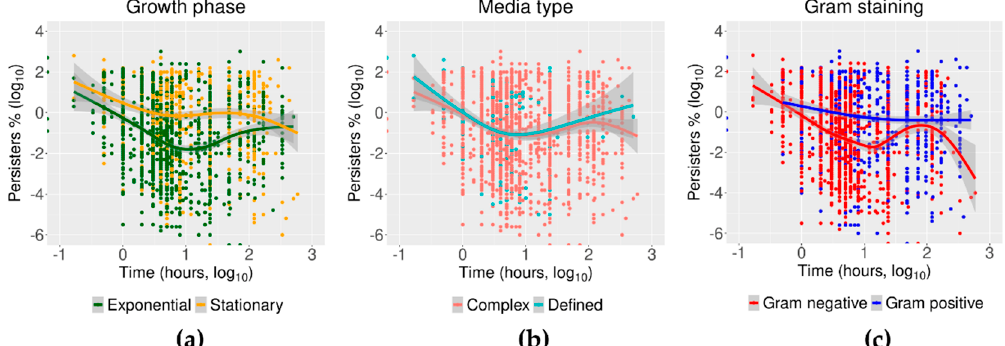
Figure 8. Time–kill curves for growth phase, media type, and Gram staining. The incubation time in the abscissa of each plot is represented as the log 10 of time in hours. The incidence of persister cells is also the log 10 of the percentage of cells growing in solid media after exposure to antibiotics in comparison to the number of cells at time zero. The number of persisters against time were fitted by local polynomial regression using weighted least squares as detailed in the methods. Growth phase: The growth-dependent data showed triphasic phases for persisters from both exponential and stationary cell cultures as described in the main text. Media type: The data grouped by media type showed no significant di ff erences except for the third phase (after 100 h) observed in the cells from cultures in complex media. Gram staining: while the fitted data for persisters in Gram-positive bacteria had a continuously descending trend, Gram-negative bacteria had a trimodal curve as described.